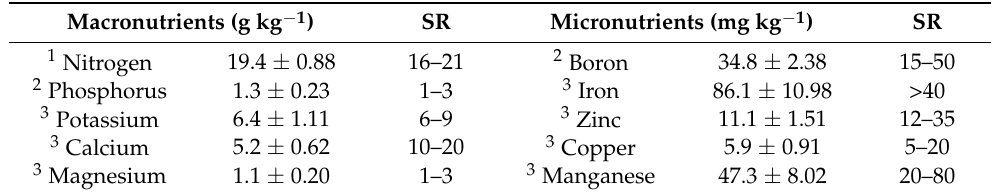
Table 9. Leaf concentration of macro and micronutrients (mean ± standard deviation, n = 3) from leaf samples taken in January 2017, and the respective sufficiency ranges (SR) for the resting period of olive, after LQARS